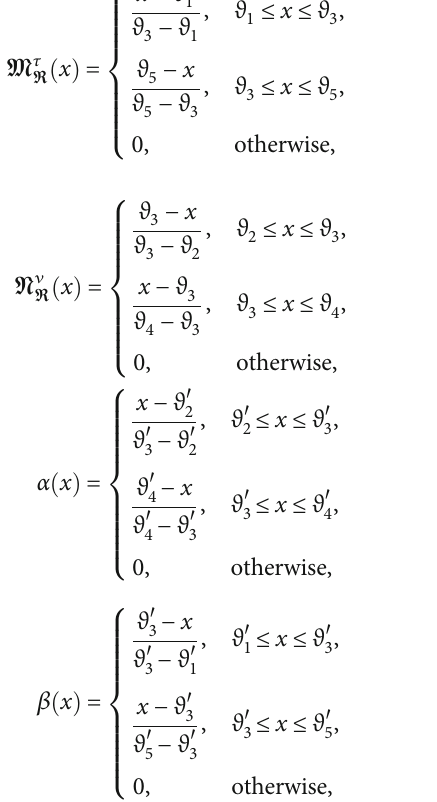
, ϑ , ϑ , ϑ , ϑ 1 2 3 4 5 Þ